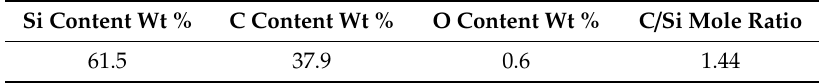
Table 1. Typical chemical composition of domestic Hi–Nicalon type SiC